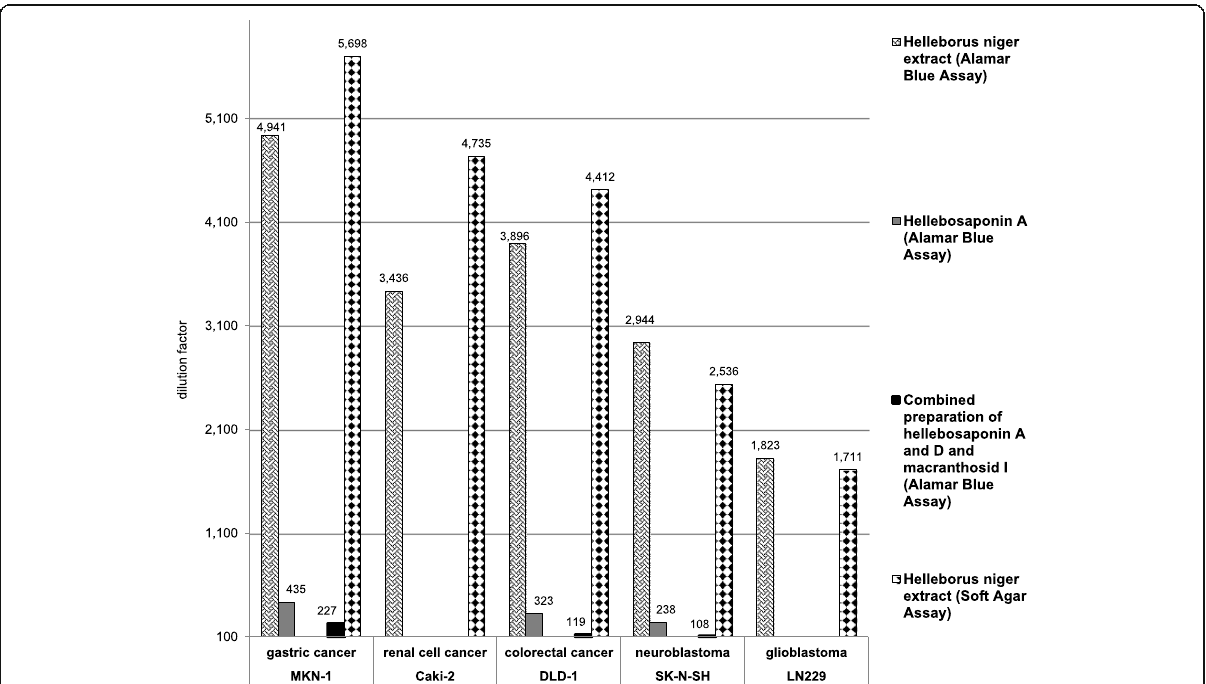
Fig. 4 IC 50 -DF of HNE and its main steroidal saponins. IC 50 -dilution factor (DF) (> 1:100) of HNE and its main steroidal saponins hellebosaponin A and D were measured in five tumor cell lines (Caki-2: renal cell carcinoma, DLD-1: colorectal carcinoma, MKN-1: gastric carcinoma, LN 229: glioblastoma, SK-N-SH: neuroblastoma) by means of Alamar Blue and Soft Agar assays. IC 50 -DF of hellebosaponin D and macranthosid I was under 1:100. These data are not shown in this figure. The IC 50 -DF of HNE comprised two batches on average